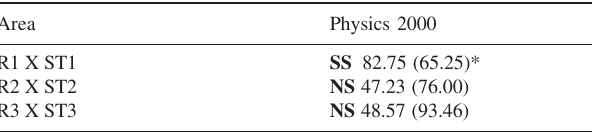
Table 6 - Comparative analysis of average correct answers in physics in 2000 (*P< 0.001)